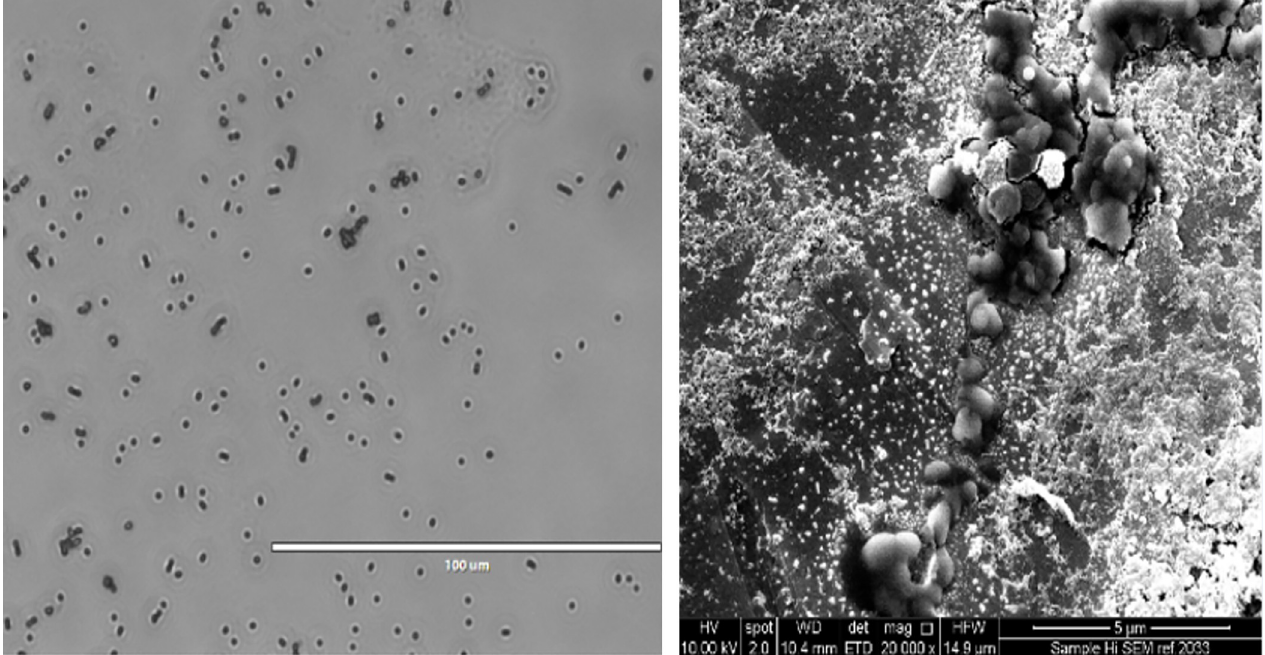
Fig 2. Light (A) and scanning electron (Bi-ii) micrographs of the formalin-inactivated bacteria used in vaccine formulations. Scale bar indicates 100 μ m (A); 5 μ m (B).